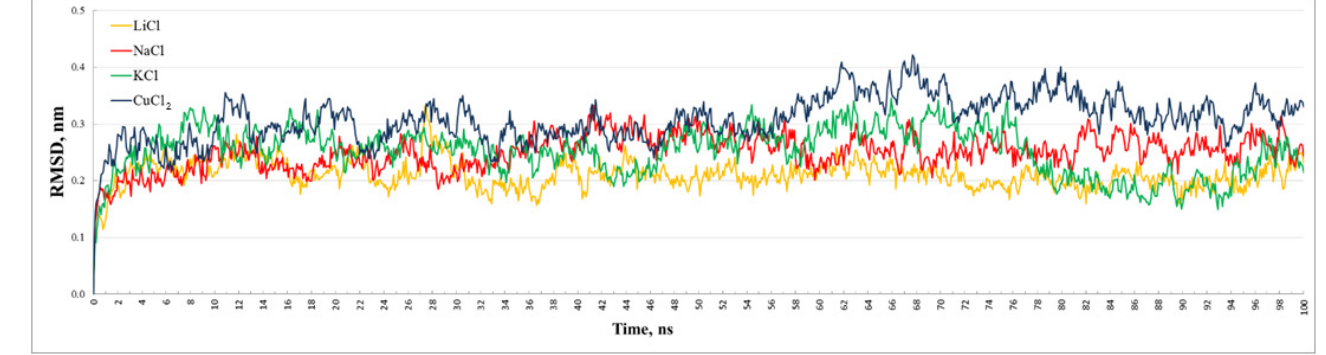
Figure 4. RMSD of dimers with different precipitants: LiCl, NaCl, KCl and CuCl 2 . In Figure 5, the RMSDs of octamers with sodium and potassium increase with time, i.e., these clusters did not manage to reach their equilibrium states in 100 ns, and their structures changed dramatically. The lithium and copper octamers retained the best similarity to their initial structures (derived from the crystal).